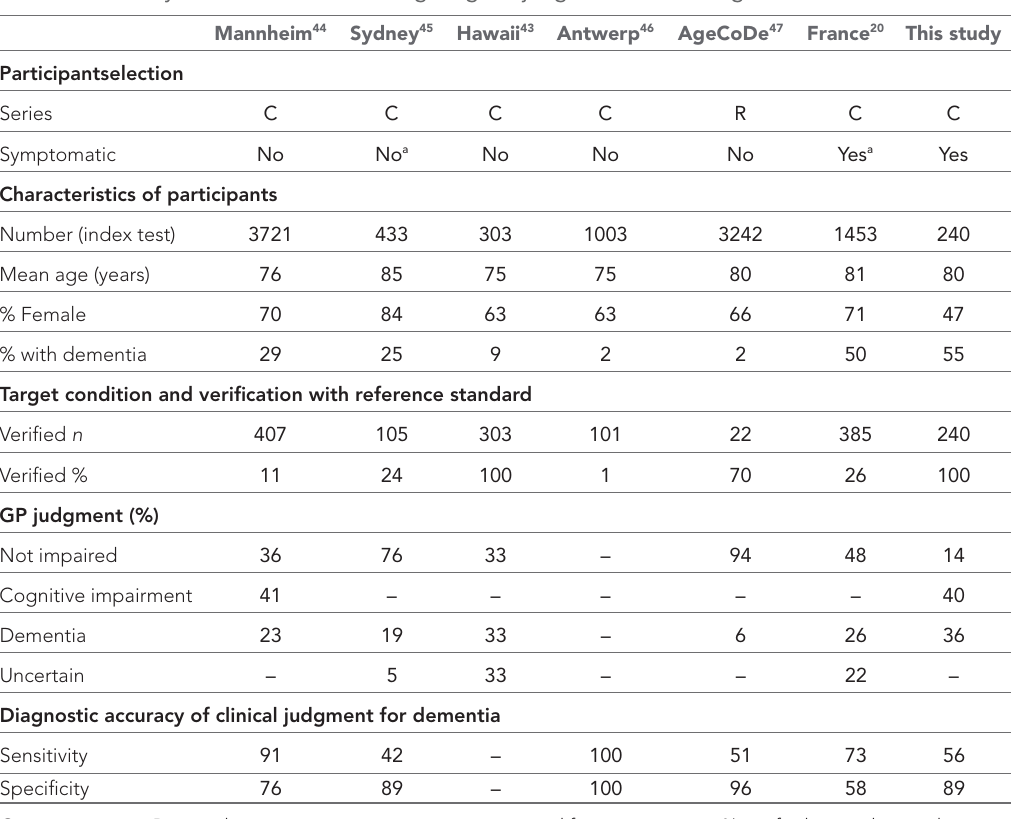
Table 3 Summary of seven studies investigating GP judgment for the diagnosis of